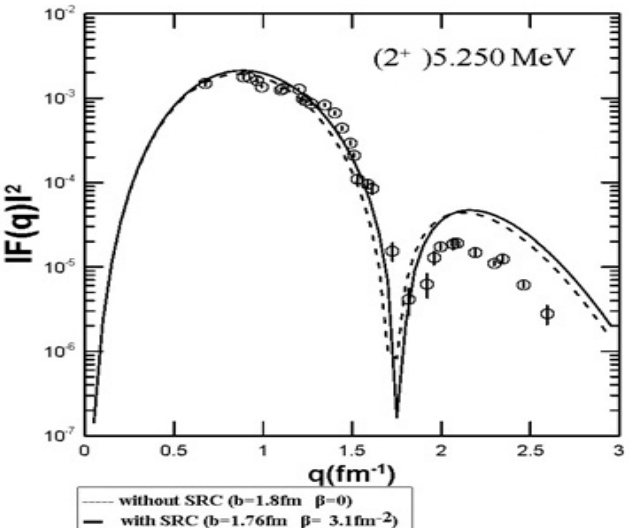
Fig. 3: Inelastic longitudinal 2 C form factors for the transition to the 12 + (5.250 MeV) state. The dashed and solid curves are the calculated 2 C form factors without and with the inclusion of the effect of the SRC, respectively. The open circle symbols are the experimental data taken from [33].